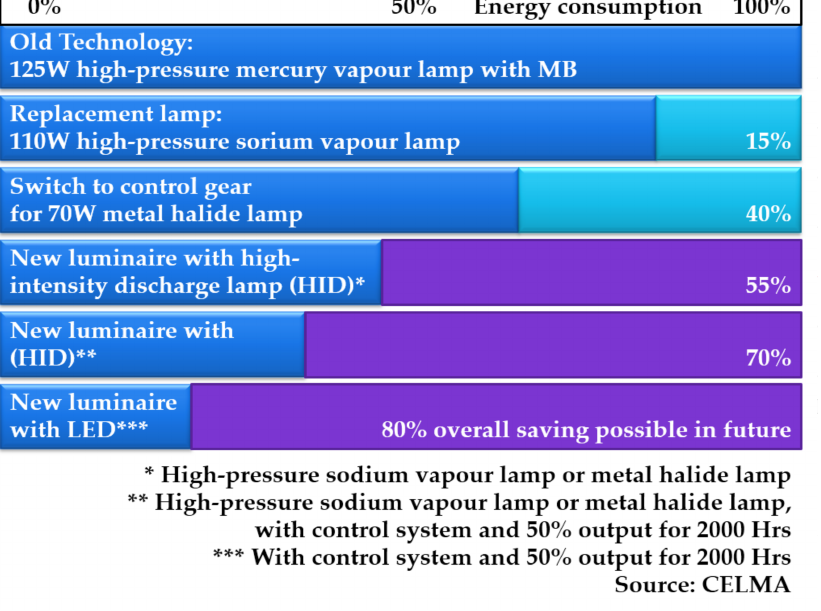
Figure 1. Theoretical energy saving potential for exterior lighting